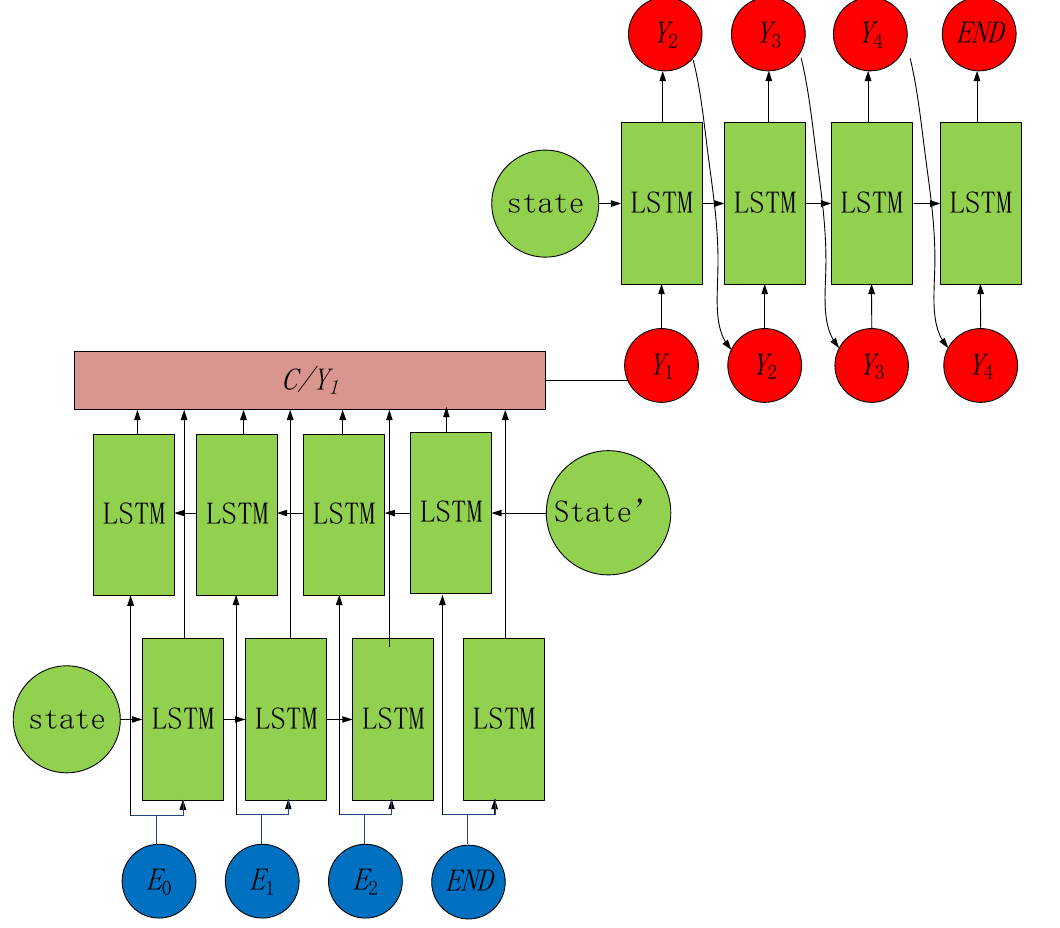
Figure 14. Conversion of the proposed encoder-decoder structure.